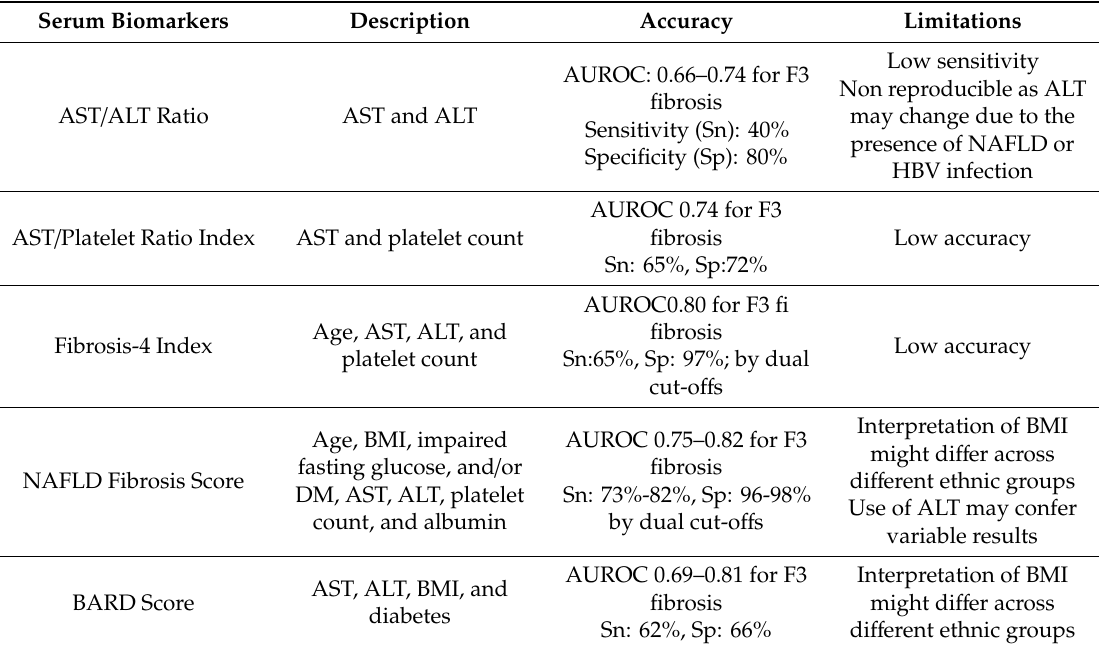
Table 3. Noninvasive biomarkers for hepatic